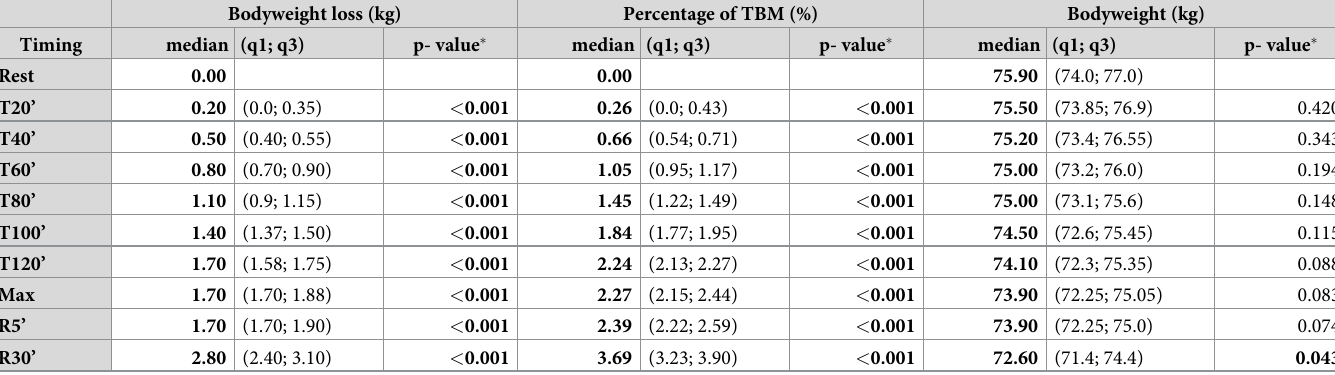
Table 2. Changes in bodyweight, rate of weight loss (kg) and % of the total body mass during the long dehydration protocol.